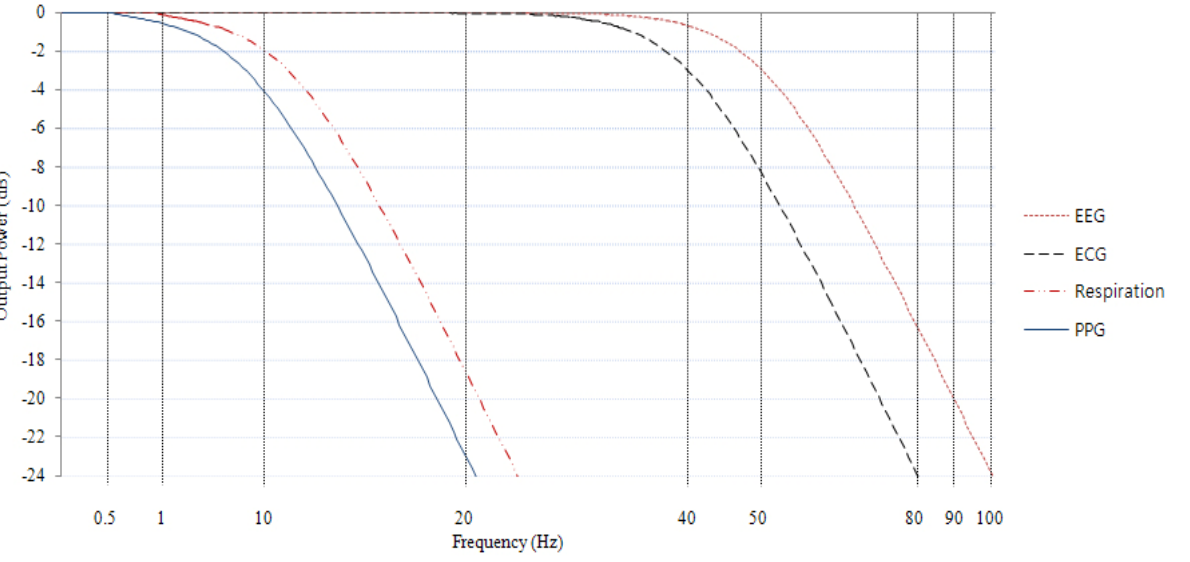
Figure 9. Amplitude frequency responses of low-pass filters inside multi sensing module.